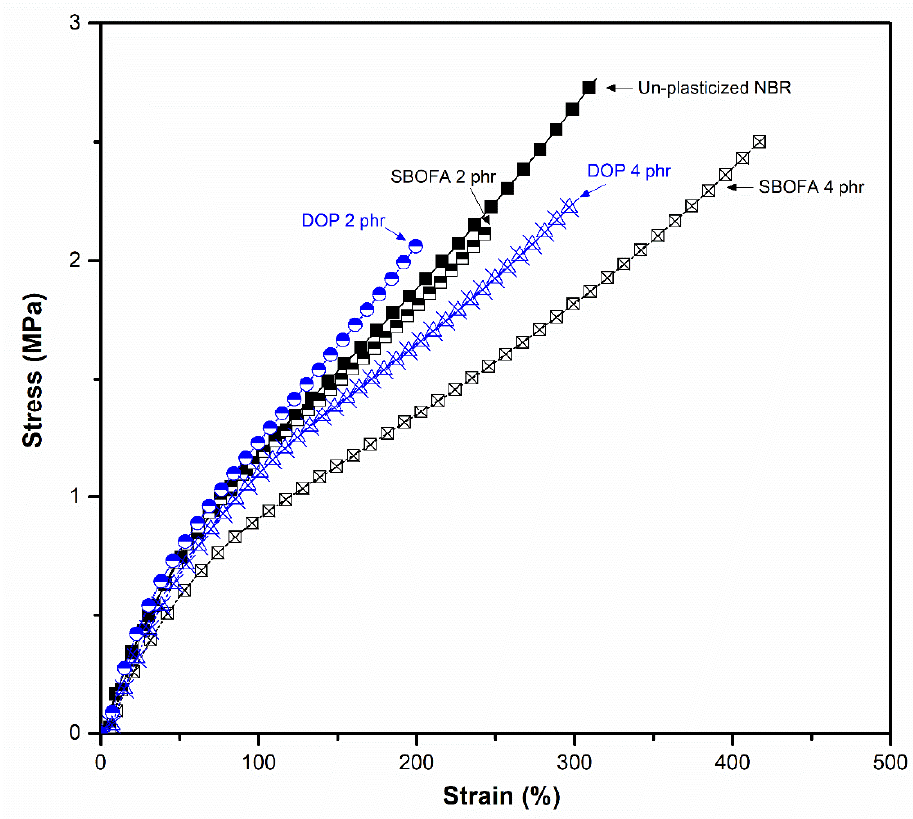
Figure 15. Representative stress–strain curves of unplasticized NBR and NBR vulcanizates with 2 and 4 phr loadings of SBO and DOP. Table 12. Mechanical properties and hardness of unplasticized NBR and NBR vulcanizates with 2 and 4 phr loadings of SBO and DOP.